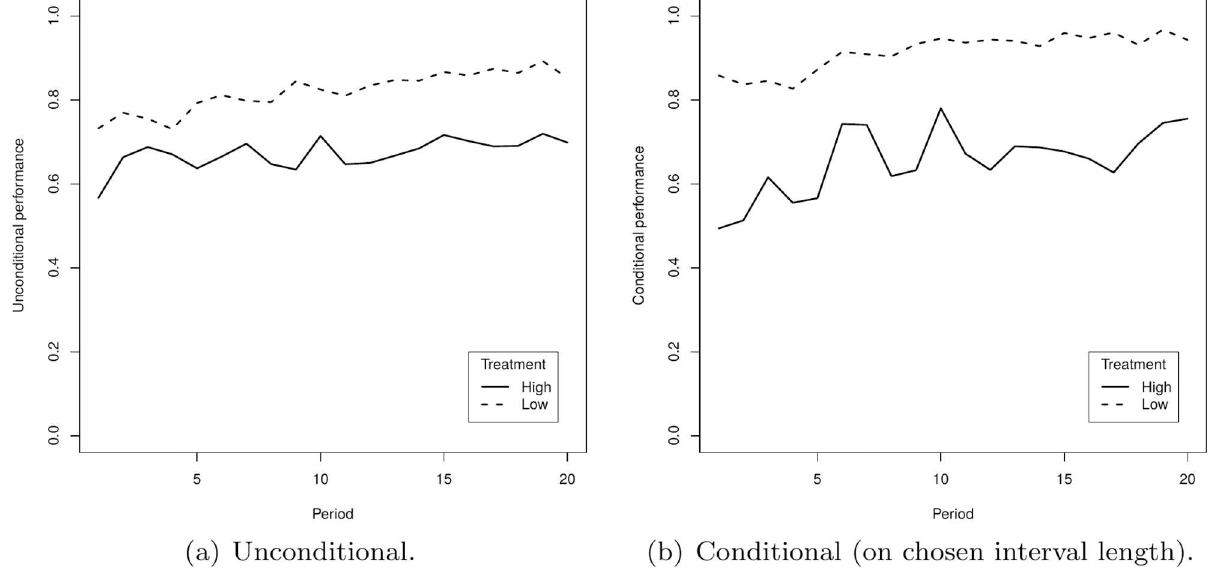
Fig 5. Performanceover time in the low volatility (dashed) and the high volatility (solid) treatment.